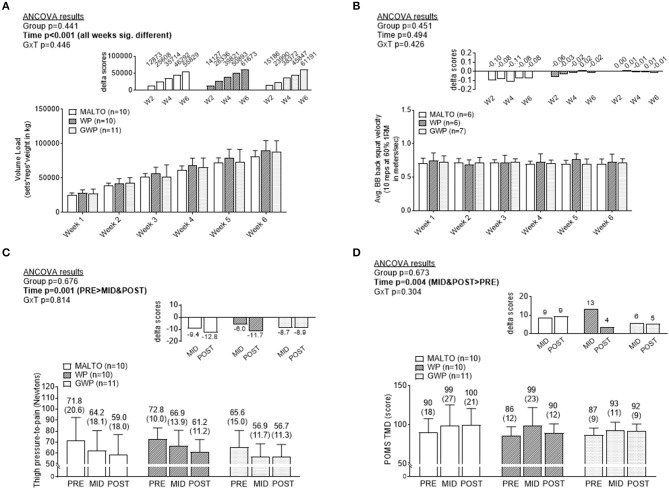
Differences in training volume, back squat lifting velocity, thigh soreness, and total mood disturbance among supplementation groups. Only a significant time effect was observed for training volume with values increasing on a weekly basis (A). No main effects or group × interaction was observed for back squat lifting velocity (B). Only a significant time effect was observed for thigh pressure-to-pain values (lower values indicates greater soreness) (C). Only a significant time effect was observed for profile of mood state (POMS) total mood disturbance (TMD) (greater values indicates more mood disturbance) (D). All data are presented as means ± standard deviation values, and values in (C,D) are indicated above each bar; values for panels a and b are not indicated due to space constraints but are provided in the raw data file. Additionally, each data panel has delta values from PRE included as inset data. MALTO, maltodextrin group; WP, standardized whey protein group; GWP, graded whey protein group.